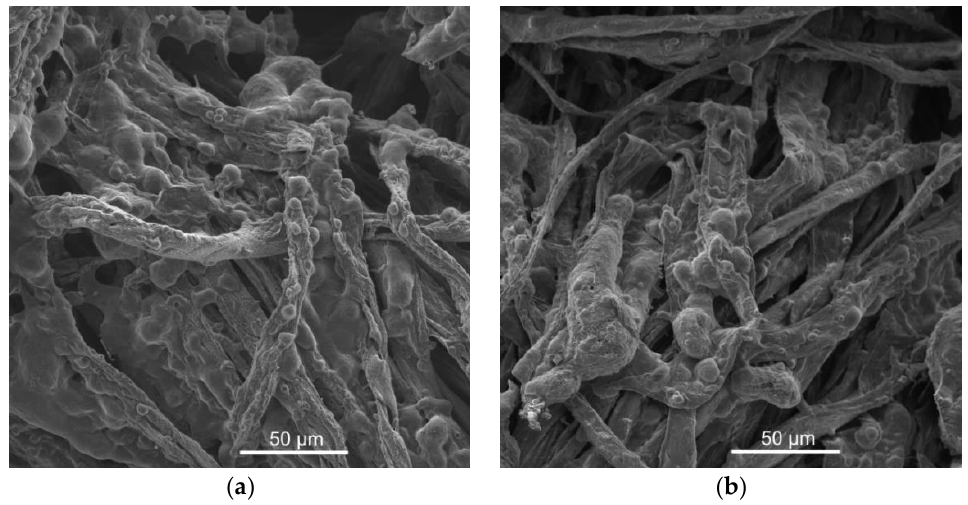
Figure 8. SEM images of post-burn char: ( a ) 8 BL; ( b ) 8 BL + Cu. To semi-quantify the amounts of phosphorus, nitrogen and copper, EDS measurements at 4 different points for each post-burn char of the treated cotton samples were performed and the average values of wt % for phosphorus, nitrogen and copper for each sample were calculated; the results are summarized in Table 5. The post-burn char mainly contains carbon, oxygen, phosphorus, and copper (for PA/CH-urea + Cu 2+ -treated samples), along with impurities such as aluminum, iron, magnesium, calcium, sulfur, and potassium (derived from the technical-grade sodium phytate). These results suggest that the deposition of PA/CH-urea and PA/CH-urea + Cu 2+ was successful. The results of the antibacterial activity of Gram-negative Klebsiella pneumoniae and Gram-positive Staphylococcus aureus after immersing LbL-treated fabric into Cu 2+ solution are summarized in Table 6. Metal ions such as Cu 2+ and Zn 2+ damage the cell membrane acting as a biosynthesis inhibitor, thus killing the bacteria [35]. As expected, all PA/CH-urea + Cu 2+ treated samples killed almost 100% of the bacteria. These results are consistent with the results obtained in a previous study, where only 2.3 wt % of copper is sufficient to kill almost 100% of the bacteria